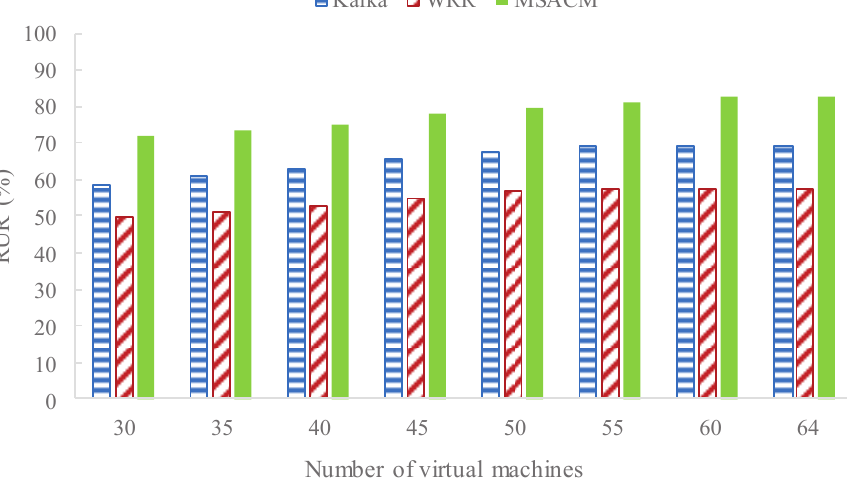
Figure 10. Resource utility rate of different numbers of online virtual